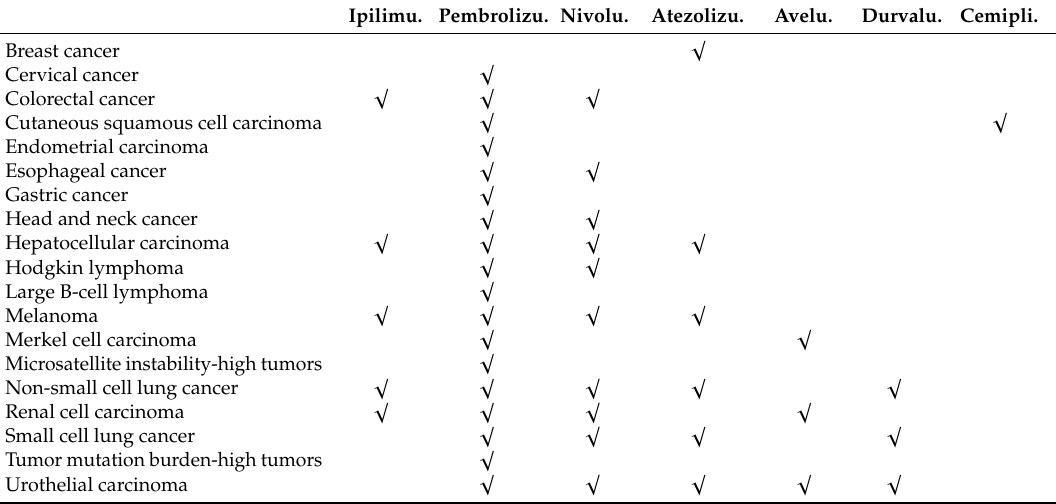
Table 2. The authorized therapeutic indications of the ICPI available in the pharmaceutical